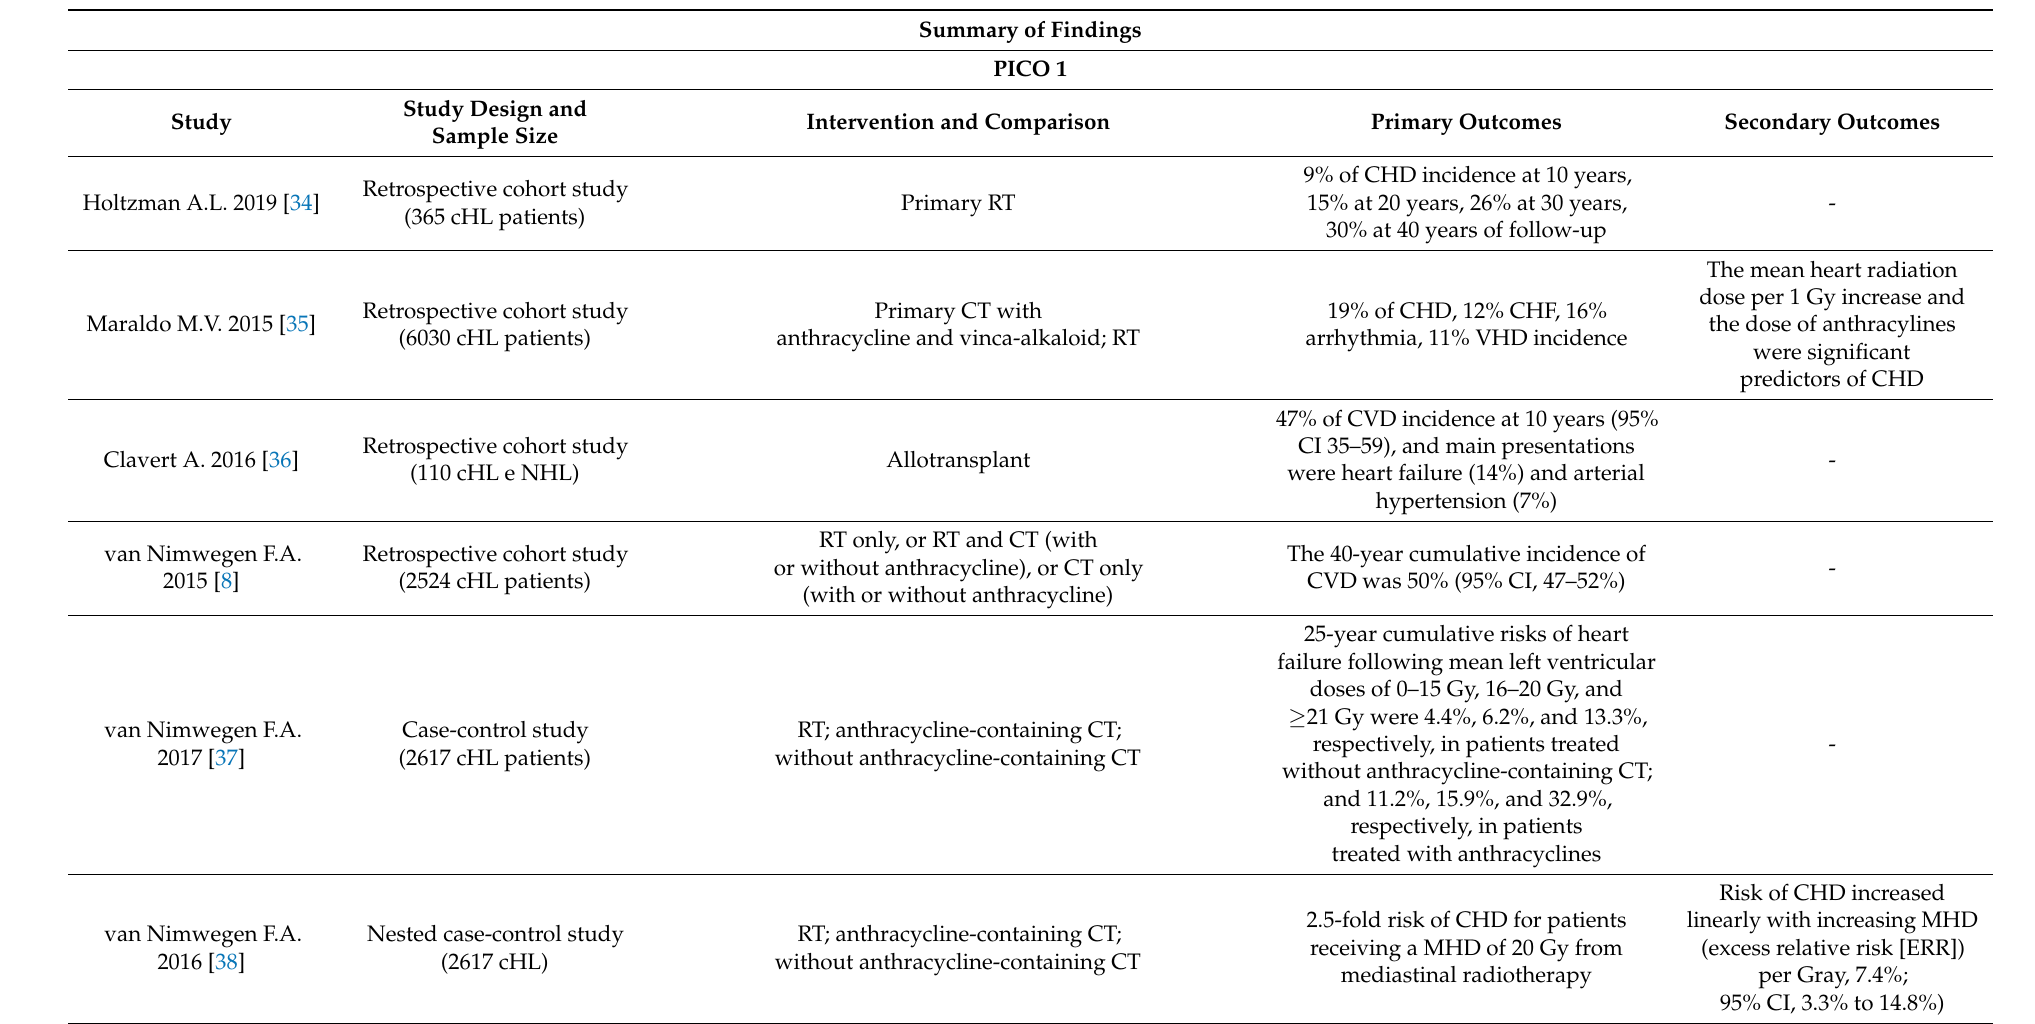
Table 2. Summary of